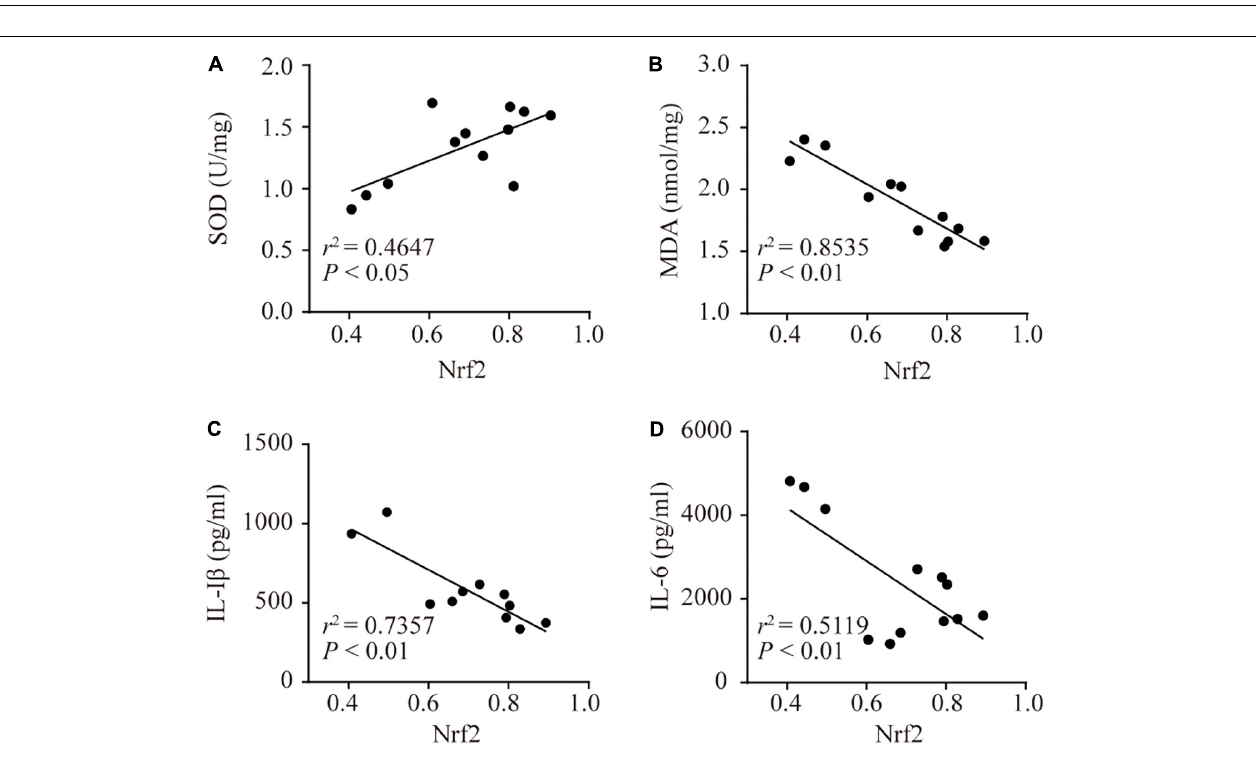
FIGURE 6 | The correlations between Nrf2 and SOD, MDA, IL-1 β , and IL-6. Associativity between Nrf2 and SOD ( A , r 2 = 0.4647, P < 0.05), MDA ( B , r 2 = 0.8535, P < 0.01), IL-1 β ( C , r 2 = 0.7357, P < 0.01), and IL-6 ( D , r 2 = 0.5119, P < 0.01).